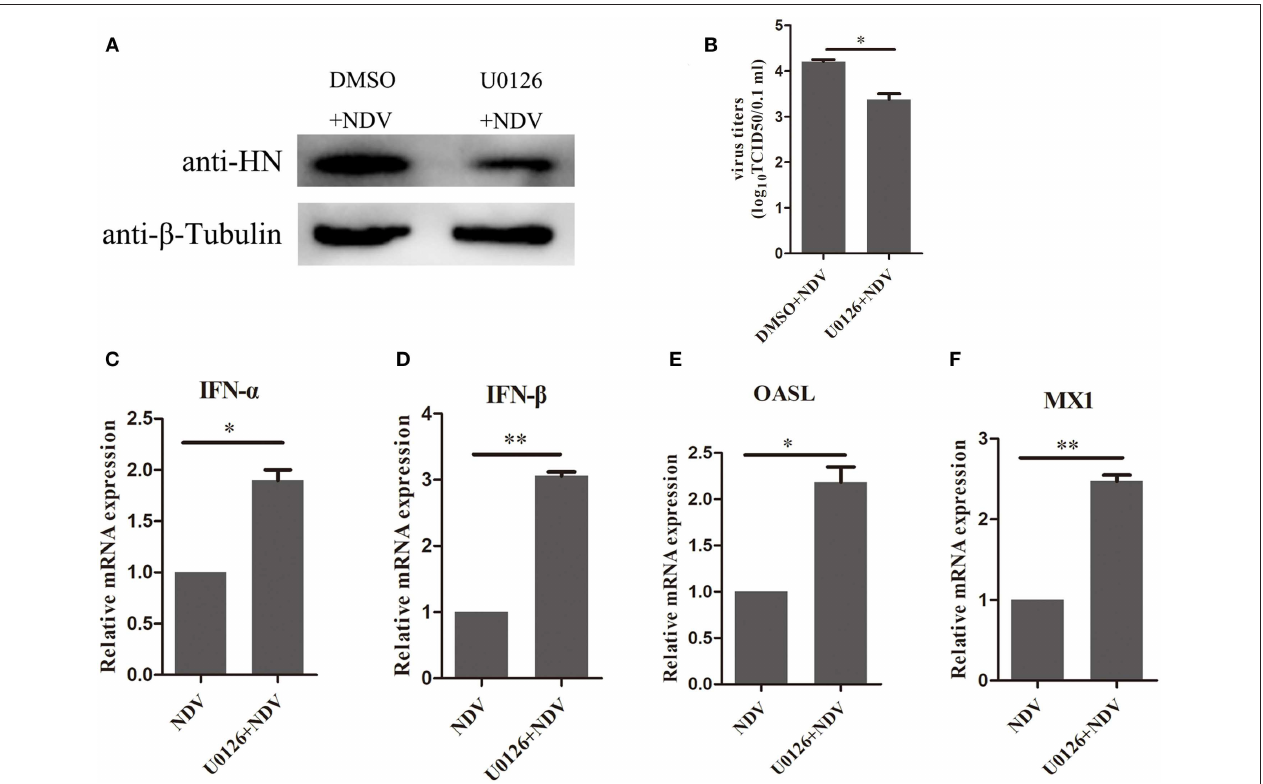
FIGURE 7 | Inhibition of MEK/ERK pathway inhibited NDV replication by improving the expression of antiviral genes. CEF cells were treated with 20 µ M of the ERK 1/2 inhibitor U0126 or DMSO for 12h and infected with NDV (0.1 MOI). Cells and cellular supernatant were harvested at 24 hpi. WB (A) and TCID50 (B) was used to detect NDV replication. (C–F) qRT-PCR was used to detect the expression of IFN α , IFN β , OASL, and MX1. Data presented are from three independent experiments and presented as mean ± SD. * P < 0.5, ** P <